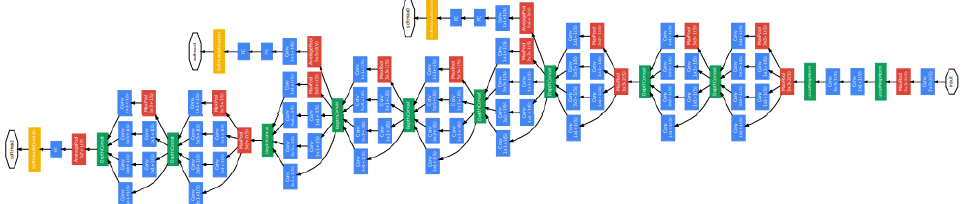
Figure 13. GoogLeNet architecture [138].